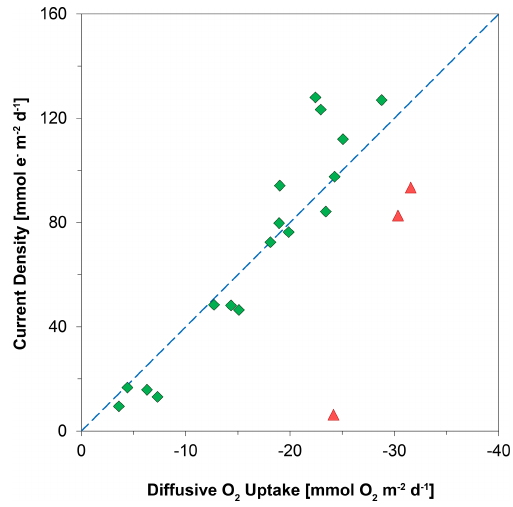
Figure 9. The relationship between the diffusive uptake of O 2 (mmolO 2 m − 2 d − 1 ) and the current density of long-distance elec- tron transport (mmol e − m − 2 d − 1 ). Red triangles are data for days 0 and 5. Green diamonds are data for all other time points. The blue line represents the expected correlation between the cathodic O 2 consumption rate and the current density, assuming a 1:4 ratio (Nielsen et al., 2010). Here, a positive value indicates an upward flux, whereas a negative value represents a downward